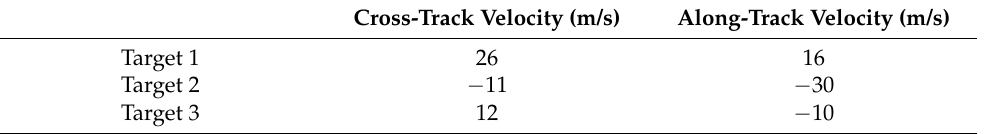
Table 2. Simulation parameters of three moving